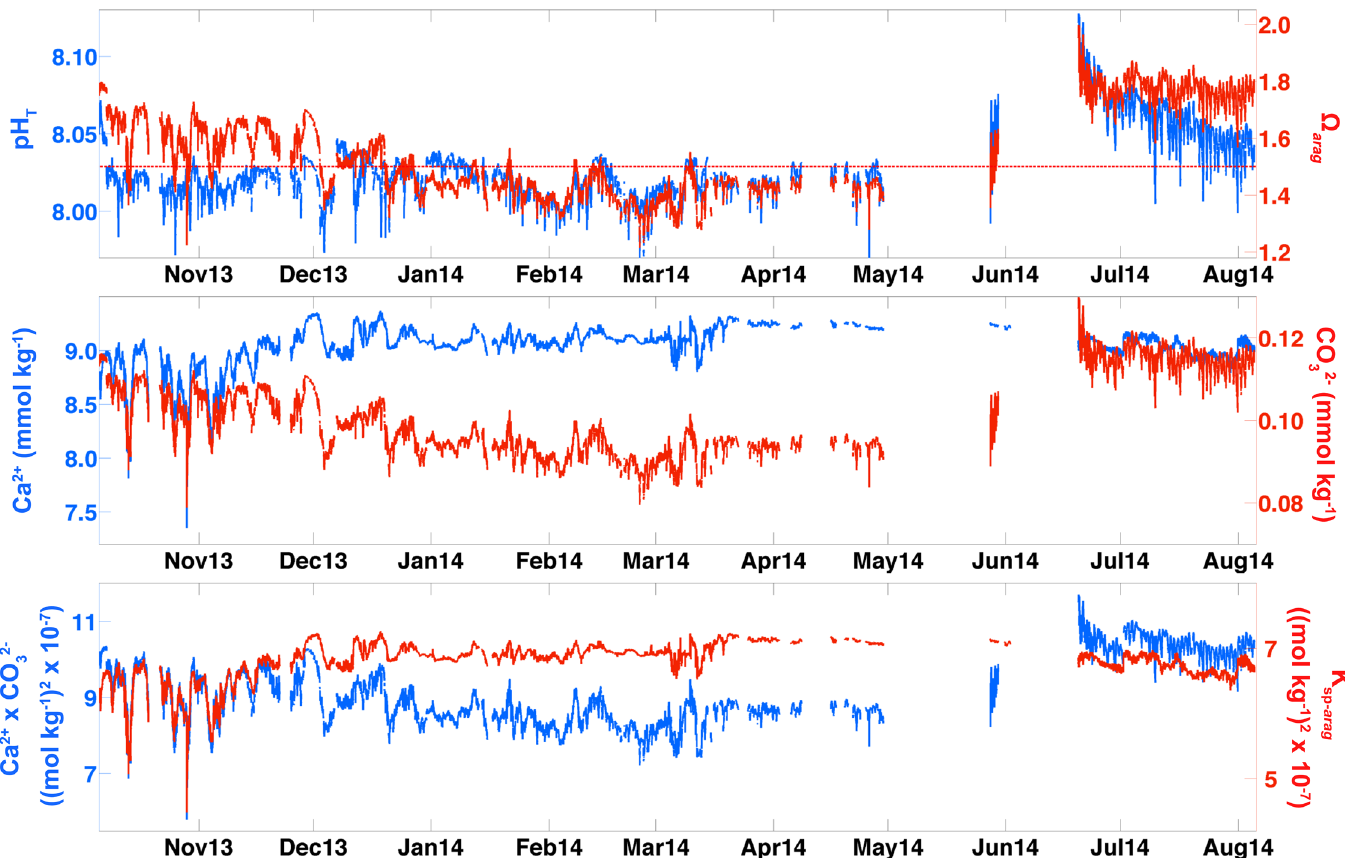
Fig 4. Top panel is pH on the total hydrogen ion scale (pH T ) and the saturation state of the aragonite phase of CaCO 3 ( Ω arag ). The dashed red line is the sub-optimal 1.5 Ω arag threshold. Subsequent panels are a decomposition of Ω arag components: middle panel is calcium (Ca 2+ ) and carbonate (CO 3 2- ) concentrations (mmol kg -1 ), and bottom panel is Ca 2+ x CO 3 2- ((mol kg -1 ) 2 x 10 − 7 ) and the solubility product for aragonite (K sp-arag ; (mol kg -1 ) 2 x 10 − 7 ).